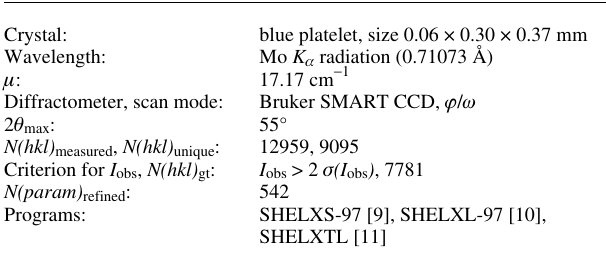
Table 1. Data collection and